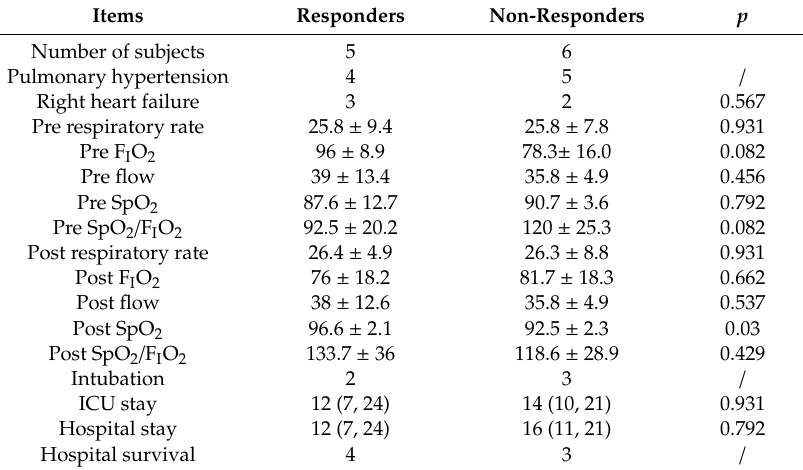
Figure 2. SpO 2 / F I O 2 pre and post iEPO via HFNC was initiated. SpO 2 pulse oximetry saturation; F I O 2 fraction of inspired oxygen; iEPO inhaled epoprostenol; HFNC high-flow nasal cannula. Table 2. Comparison between responders and non-responders.